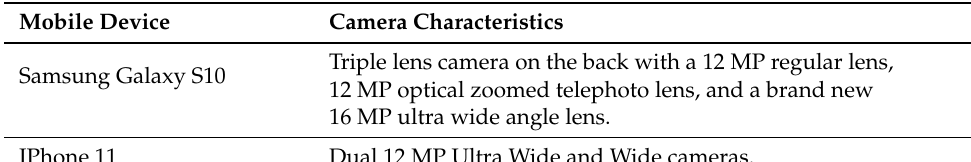
Table 1. Mobile Devices Camera